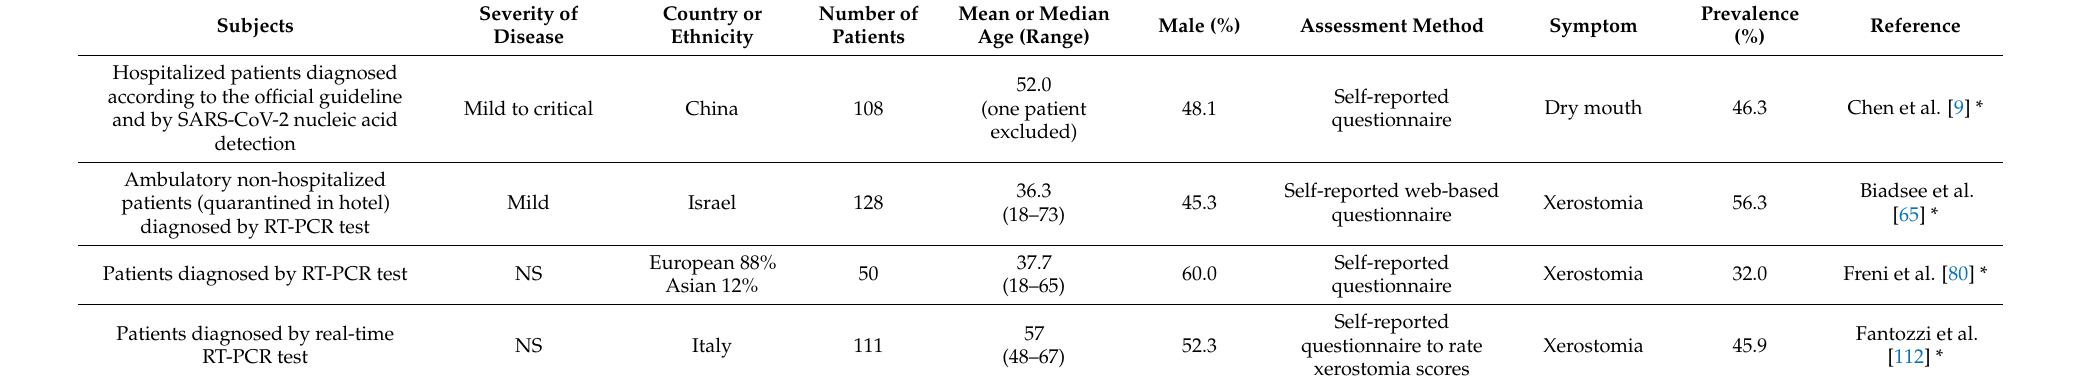
Table 2. Xerostomia associated with coronavirus disease 2019